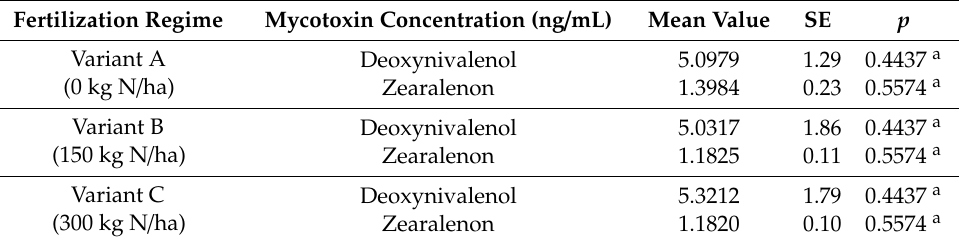
Table 4. Fertilization e ff ects on mycotoxin concentration in plant